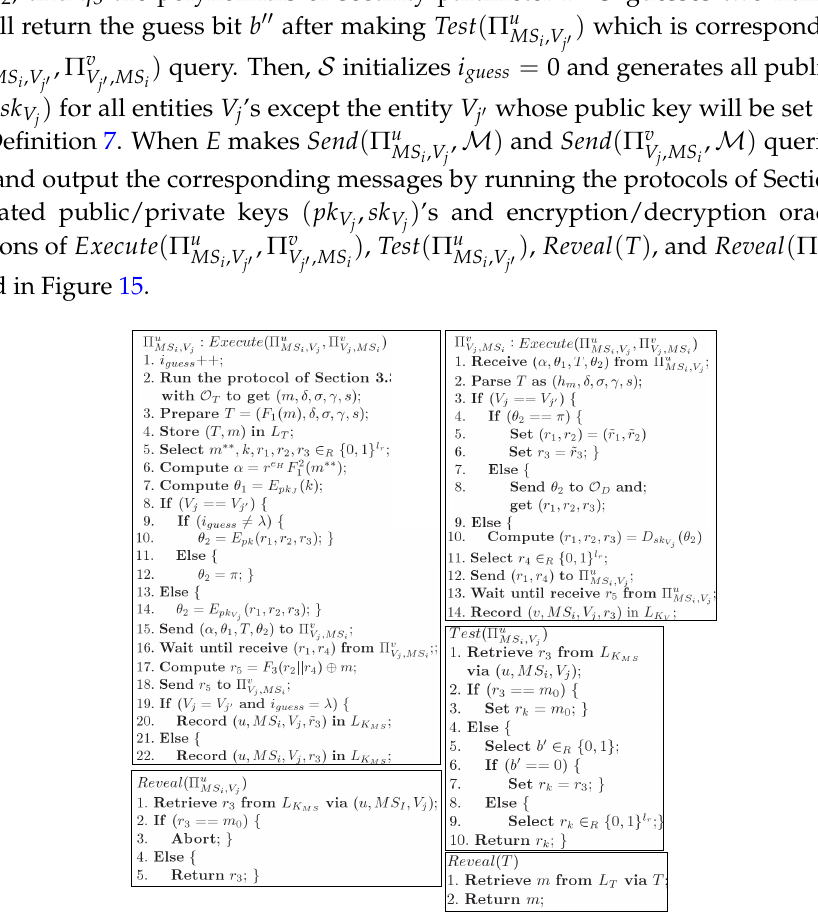
Figure 15. The oracles in the proof model of Theorem